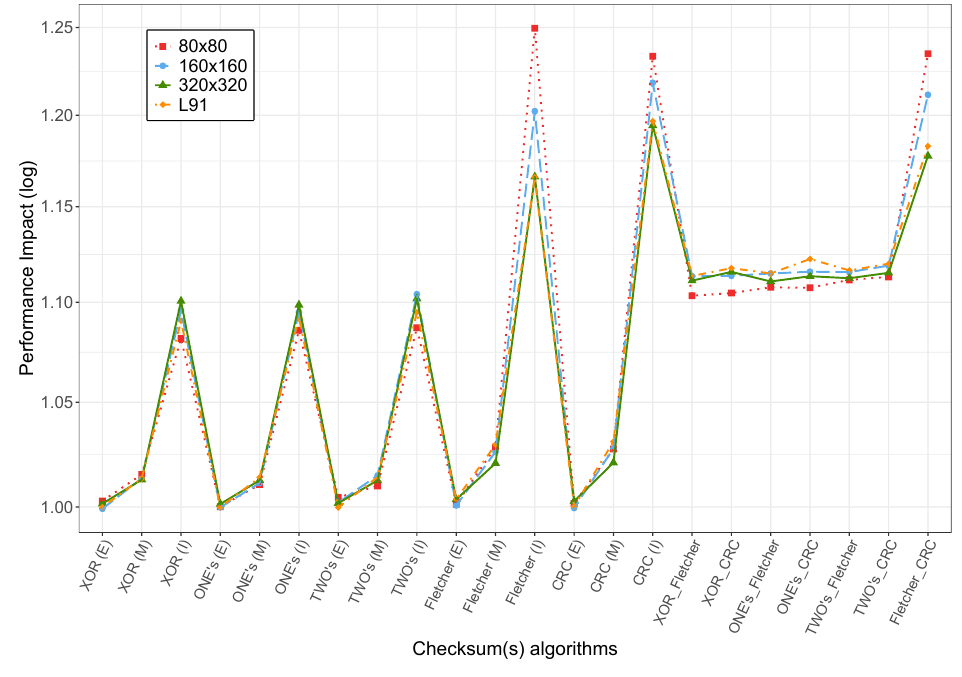
Figure 5. Performance impact with -O0